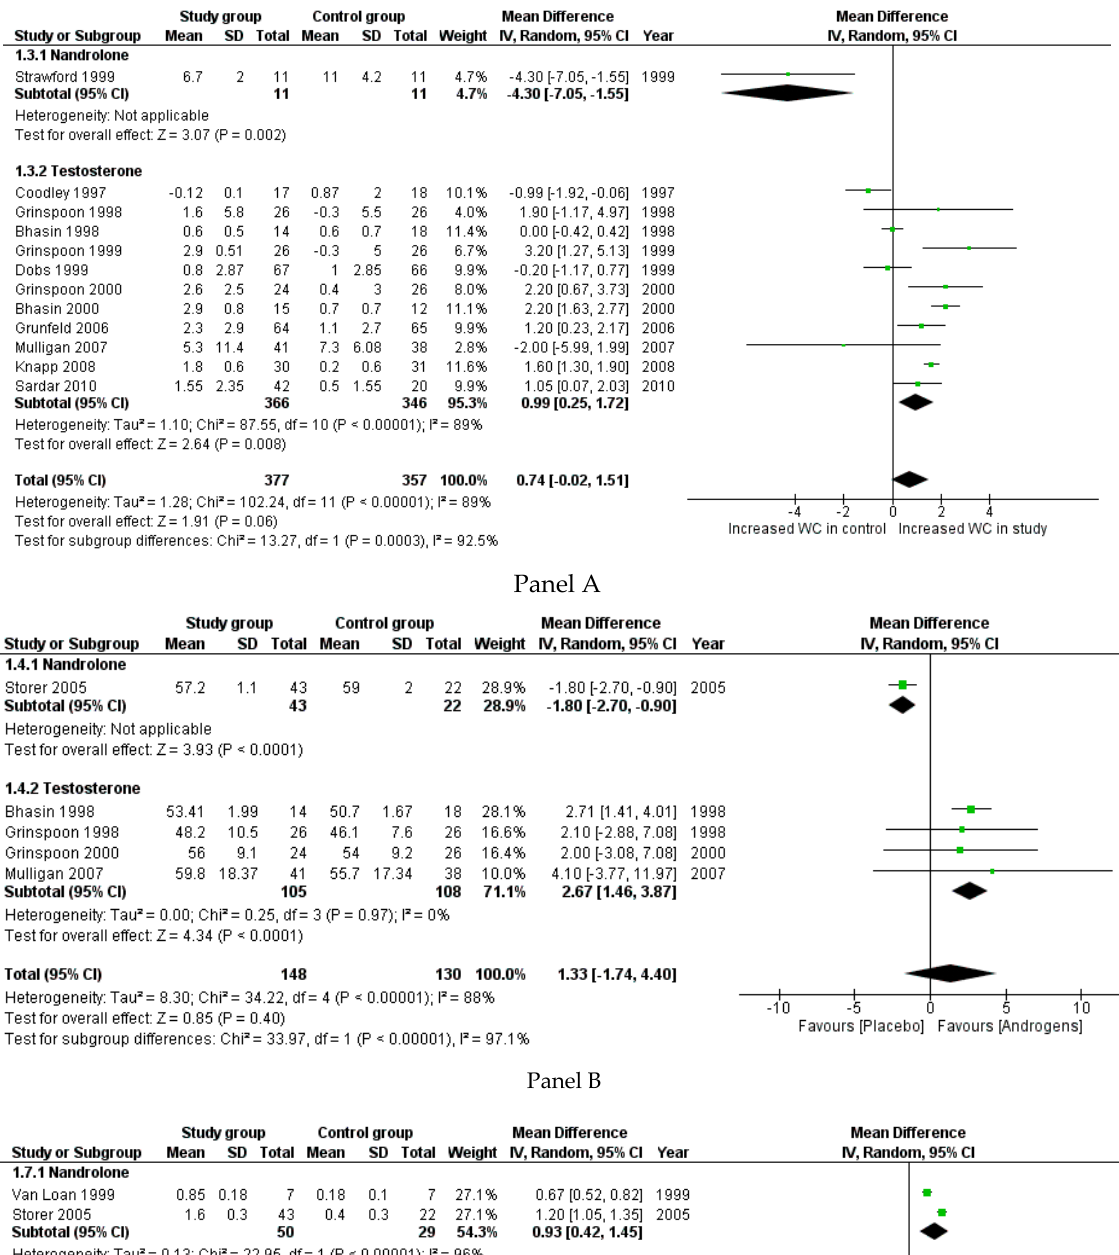
12 of 21 Panel C Figure 4. Forest plot reporting groups detected in the second literature search for changes in sex hormone binding globulin (SHBG) between study and control groups (Panel A ). Panel B reports the sensitivity analysis for hypogonadism, and Panel C shows the sensitivity analysis for wasting syndrome. 3.6. Body Composition Body composition parameters were assessed by dual energy x-ray absorptiometry (12 studies) or by bioelectrical impedance analysis (five studies). Body weight changes (WC) were reported in 12 studies, for a total of 734 patients. WC was lower when a placebo was administered instead of androgen therapy, although the difference did not reach a statistically significant level ( p = 0.060) (Figure 5, Panel A). How- ever, in 11 trials, Te was dispensed, whereas only one study used nandrolone (N). Consid- ering only the action of Te, and comparing treated and untreated patients, the WC increase was significantly higher in the study group than in the control group ( p = 0.008) (Figure 5,